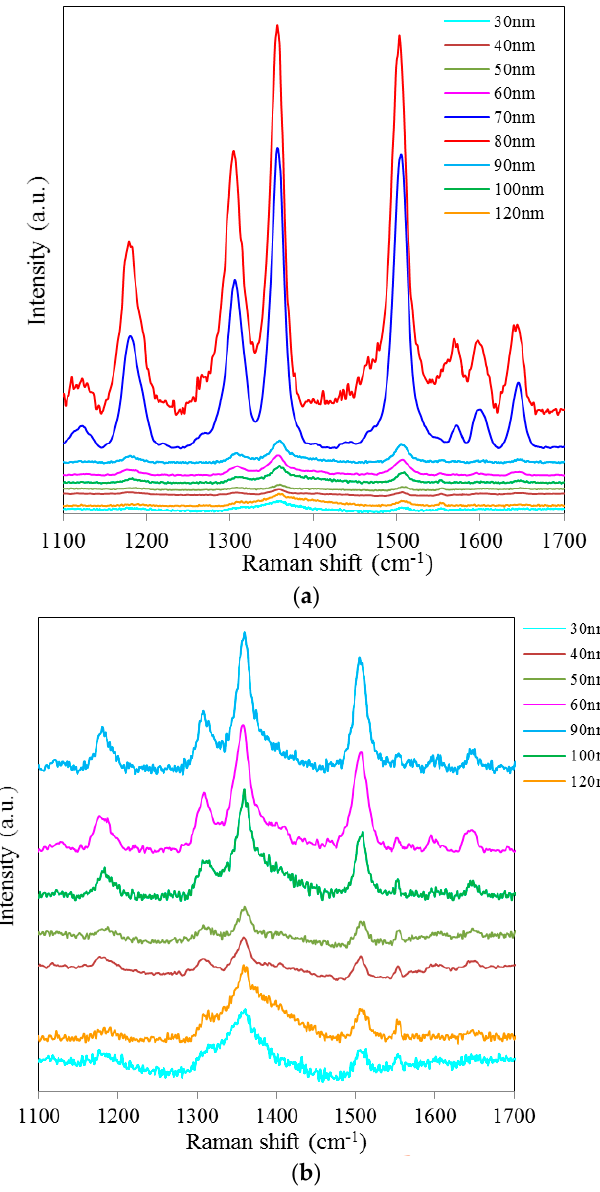
Figure 2. SERS spectra of 8 × 10 − 5 M solution of Rh6G dye adsorbed on the surface of 35 nm NAAO substrate coated with 30, 40, 50, 60, 70, 80, 90, 100 and120 nm gold films measured with 3 s integration time ( a ); Figure ( b ) shows the relative enhancement of the weak Raman signals after removing the spectra for the 70 and 80 nm gold coated 35 nm pore size substrate measured with 3 s integration time.